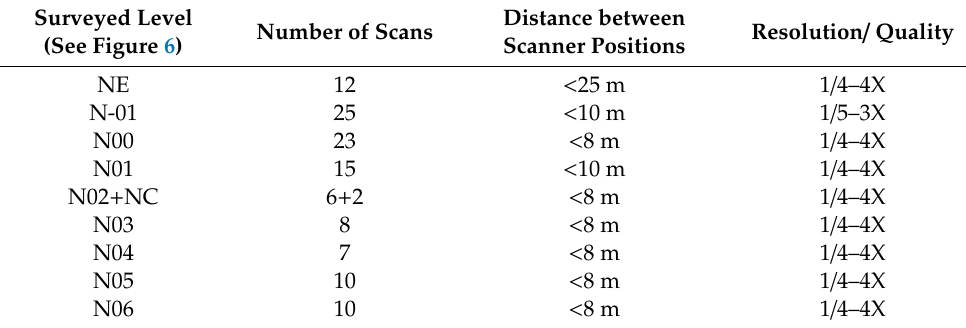
Table 1. Configuration Parameters for the 3D TLS Survey with Focus 3D X330.